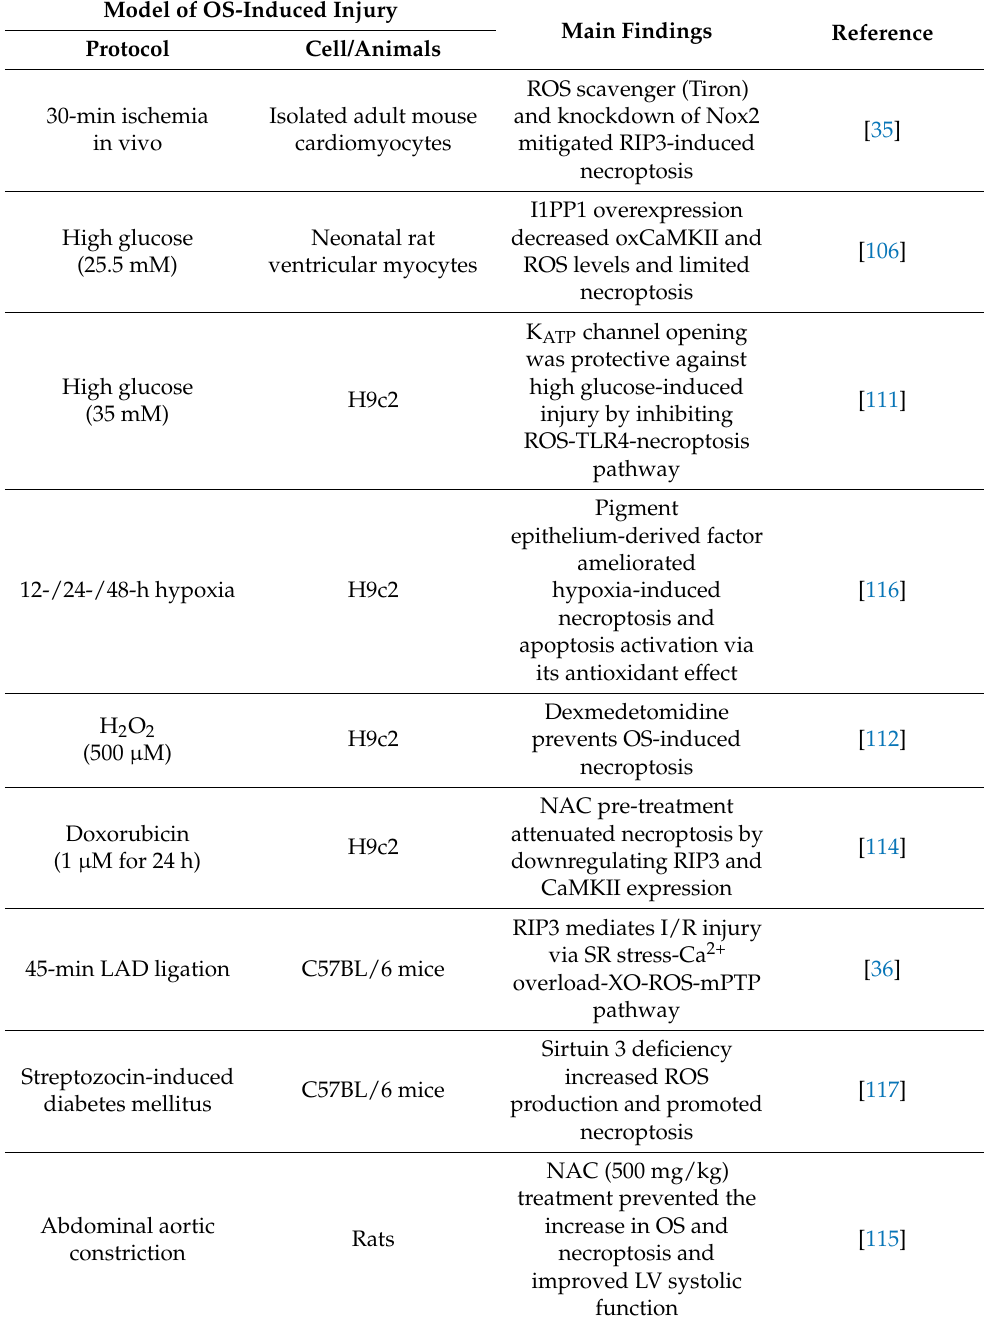
Table 2. A list of studies showing a link between oxidative stress and